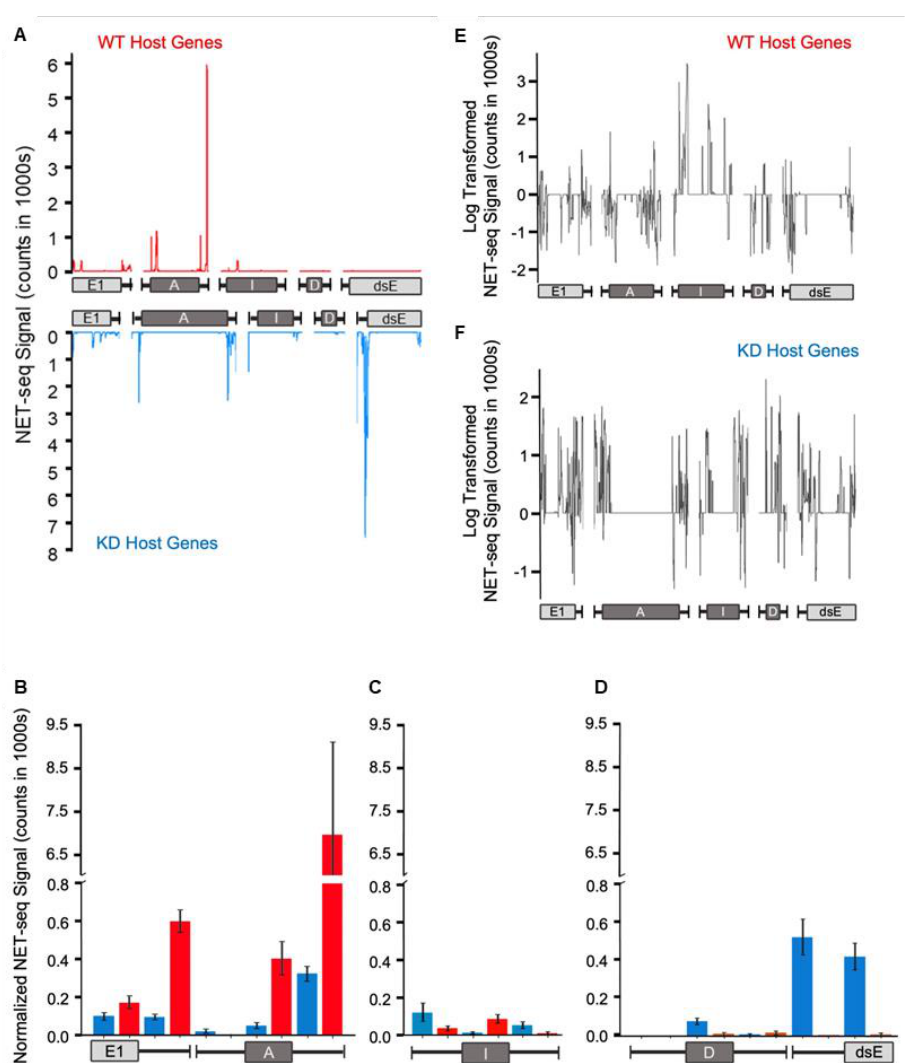
Figure 7. circRNA host genes in PARP KD exhibit distinct pausing profiles compared to WT circRNA host genes. NET-seq data were used to measure RNAPII pausing in WT and PARP KD conditions. Pausing was measured at exons (boxes) and 300 bp upstream and downstream of exons (solid lines). For each set of host genes, pausing within gene bodies was measured at exon 1 (E1) upstream of circRNA exons, the circRNA acceptor exon ( A ), the circRNA internal exons (I), the circRNA donor exon ( D ), and the exon downstream of the circRNA region (dsE). ( A ) RNAPII accumulates early in WT host genes (top) compared to pausing within PARP KD host genes (bottom) where RNAPII stalls at the dsE. ( B – D ) Bar chart showing a side-by-side comparison of the differences in RNAPII accumulation at specific host gene regions as described in ( A ). The differences in RNAPII pausing upstream of the acceptor and acceptor regions of the circRNA are shown in ( B ), while ( C ) and ( D ) show differences in RNAPII pausing internal to the circRNA and downstream of the donor exon of the circRNA, respectively. ( E , F ) The change in RNAPII pausing within WT ( E ) and PARP KD ( F ) host genes upon PARP1